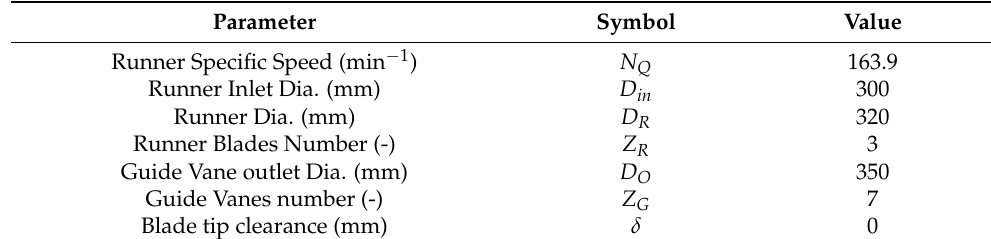
Table 1. PAT model geometric parameters.